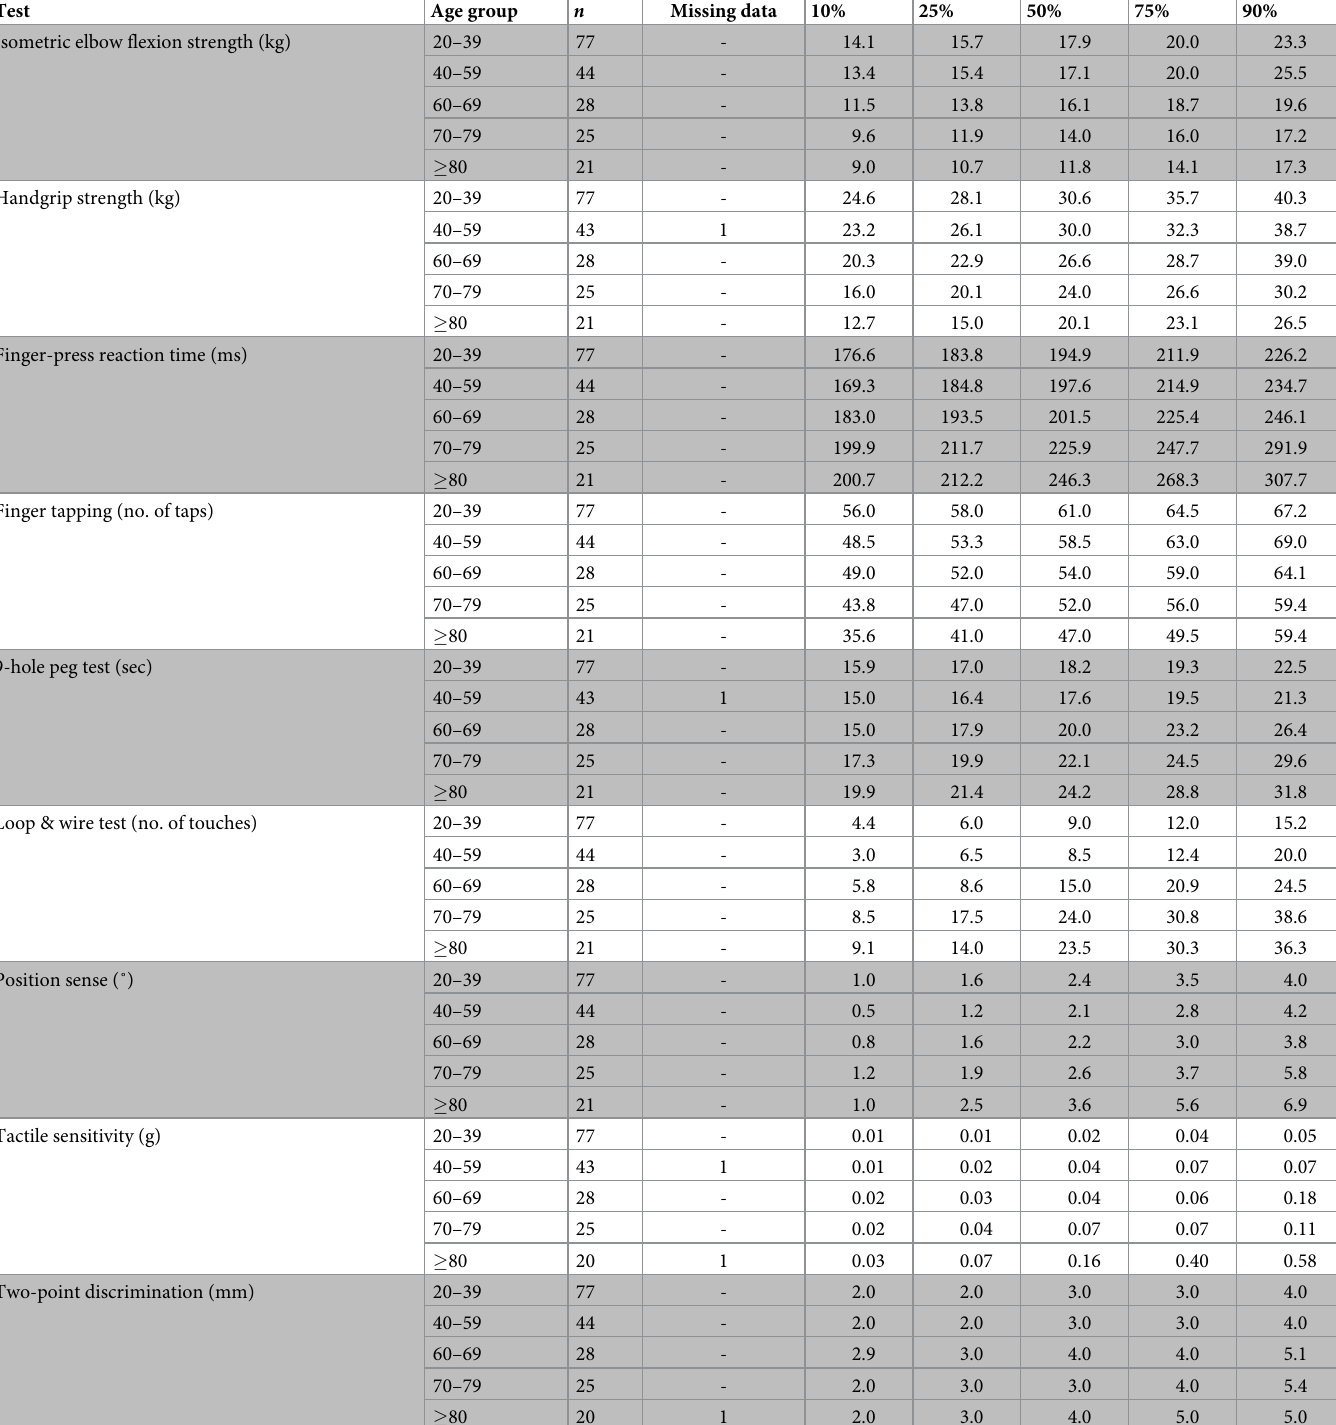
Table 3. Reference values (percentiles) for females in each upper limb PPA test for age groups 20–39, 40–49, 50–59, 60–69, 70–79 and � 80. Test Age group n Isometric elbow flexion strength (kg)